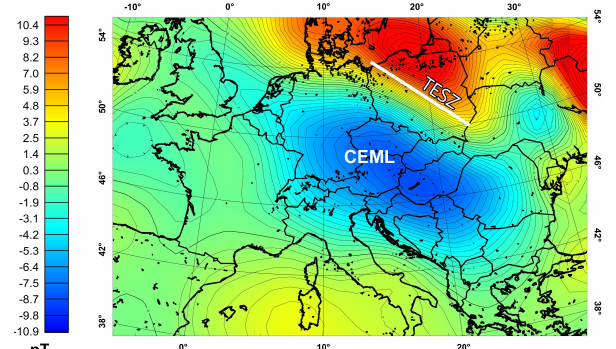
Figure 1. MF7 magnetic field model at 350km of altitude. (CEML: Central European Magnetic Low; TESZ: Trans-European Suture